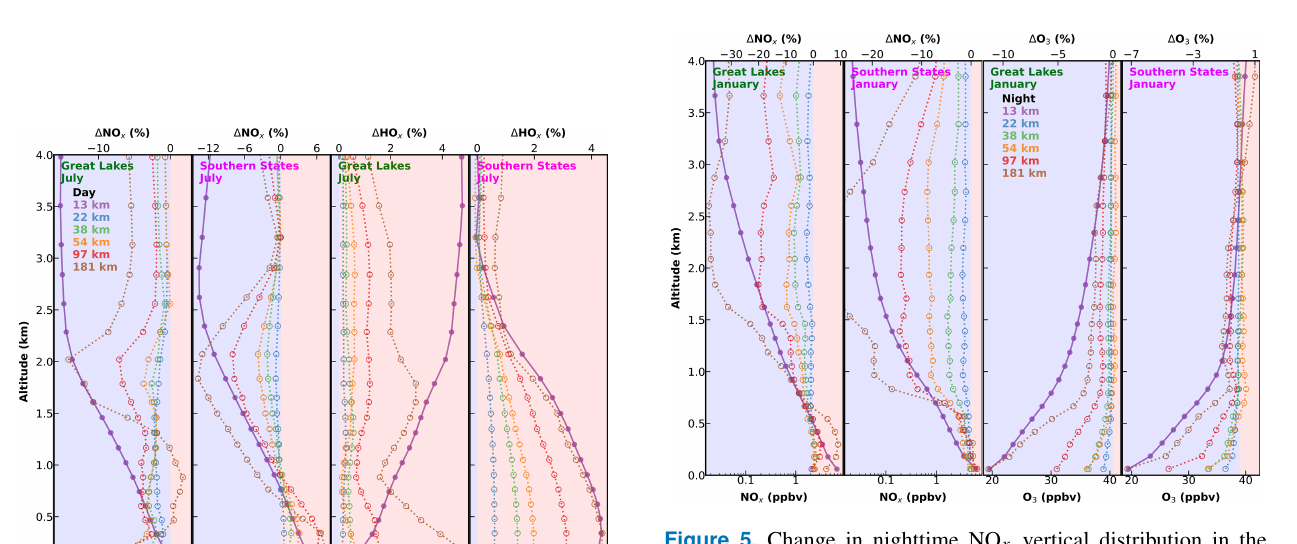
Figure 5. Change in nighttime NO x vertical distribution in the lower troposphere at different resolutions in January. Similar to Fig. 4 but for nighttime NO x and O 3 in